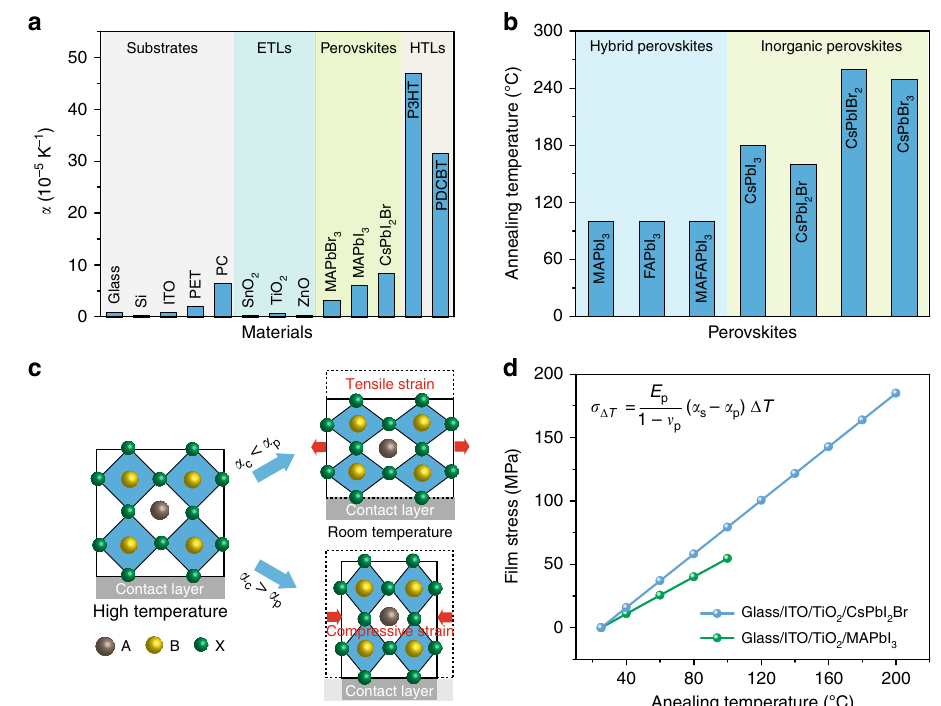
Fig. 1 Analysis of thermally-induced strain in perovskite fi lms. a Thermal expansion coef fi cients of widely-used functional layers in PSCs including substrates, ETLs, perovskites, and HTLs. b Annealing temperatures of different hybrid and inorganic perovskite fi lms during formation. c Schematic showing the formation of tensile and compressive strains. d The calculated annealing temperature-dependent stress from thermal expansion mismatch between the substrate and perovskites including MAPbI 3 and CsPbI 2